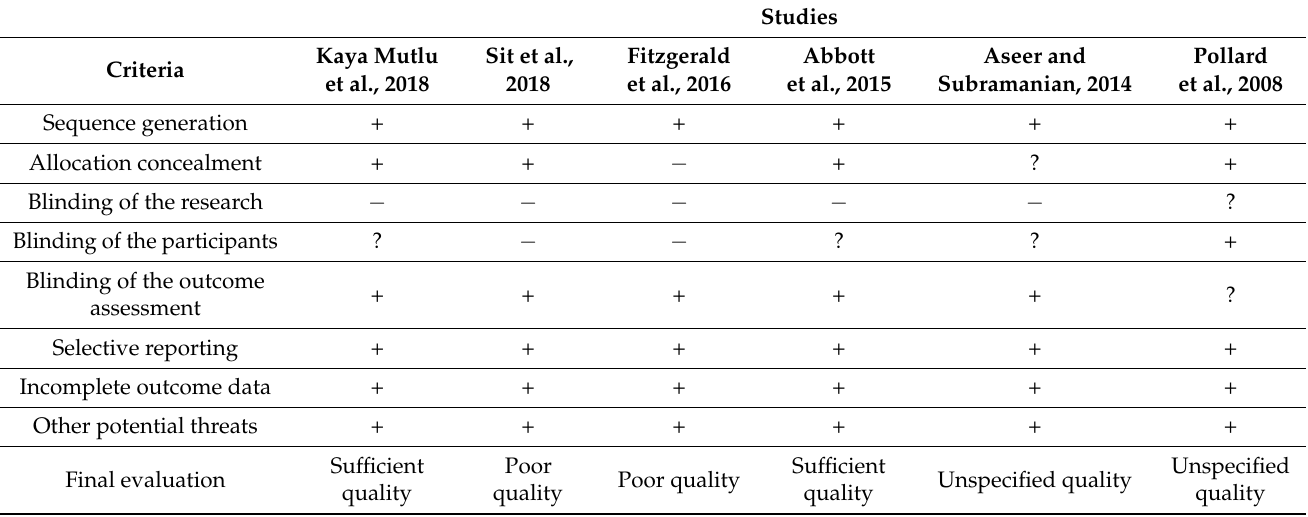
Table 3. Study evaluation based on the Cochrane risk of bias